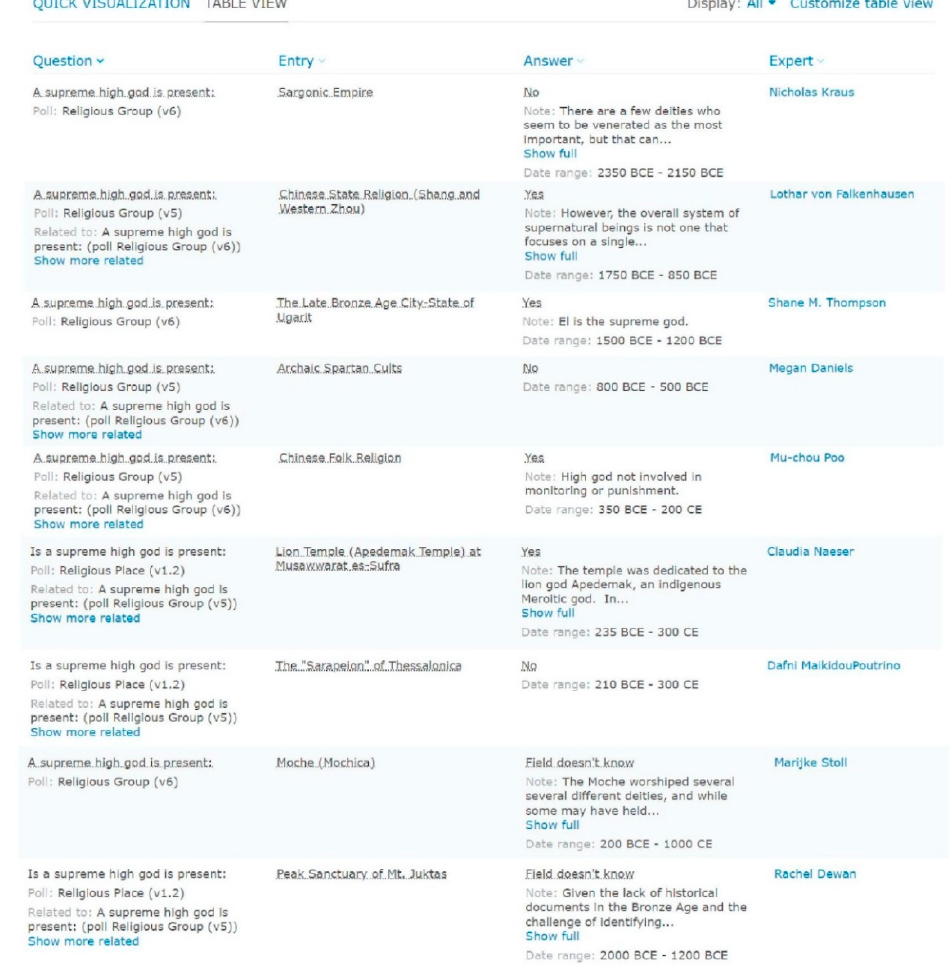
Figure 2. DRH table view of the query “ A supreme high god is present ” from 5000–0